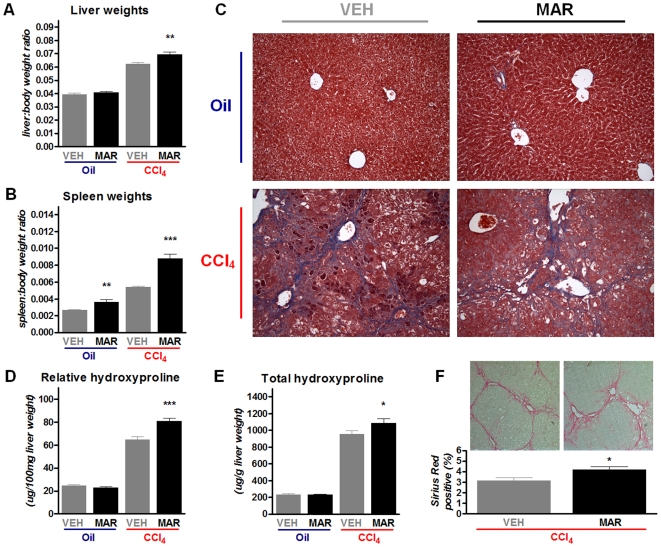
Marimastat treatment increased hepatic fibrosis following repeated carbon tetrachloride (CCl4) administration.In mice treated with Marimastat, the liver to body weight ratio (A), as well as the spleen to body weight ratio (B) were increased. Masson trichrome staining of liver sections for collagen (blue; C) revealed bridging portal fibrosis. Livers from Marimastat treated animals showed occasional focal cirrhosis; however, advanced fibrosis was predominant (C). Livers from Marimastat treated mice exhibited increased collagen deposition as determined biochemically as relative hydroxyproline content and total hydroxyproline content in liver samples from two different lobes (D, E). Relative fibrotic area was increased in livers from mice treated with Marimastat, as quantified using morphometric analysis of Sirius Red stained liver sections (F). Oil, non-fibrotic control group; CCl4, fibrotic mice; VEH, vehicle treated control group; MAR, Marimastat treated experimental group; *, P<0.05; **, P<0.01; ***, P<0.001 vs. vehicle alone. Data are expressed as means ± standard error.